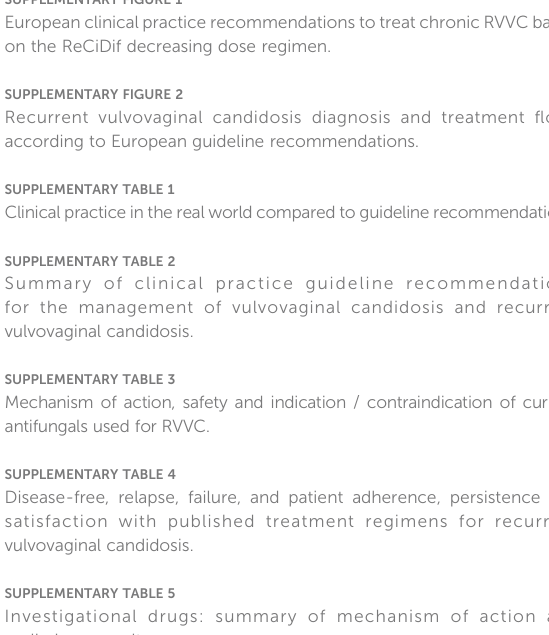
SUPPLEMENTARY TABLE 5 Investigational drugs: summary of mechanism of action and preliminary